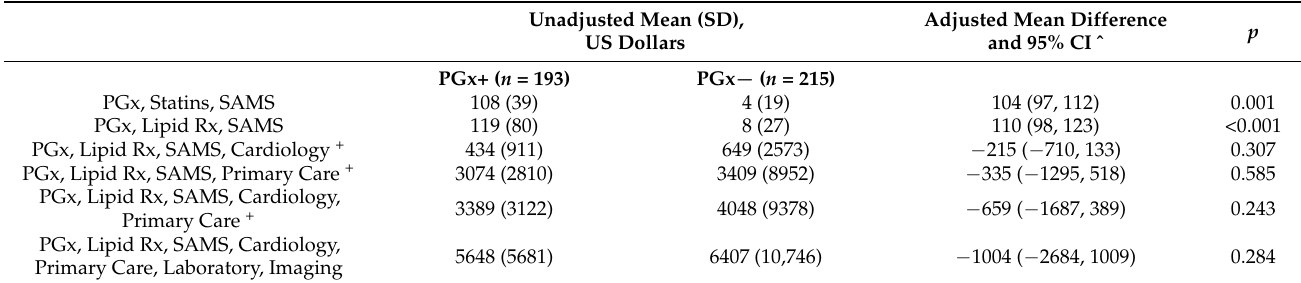
Table 3. Directly attributable mean per-patient costs for I-PICC participants over the 12-month trial period.